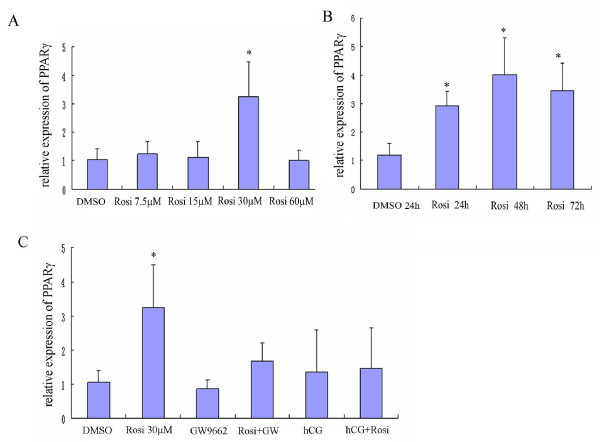
Effects of rosiglitazone on PPARγ mRNA level in cultured GLCs. A. Relative expression of PPARγ after rosiglitazone (Rosi) treatment for 72 h in different doses. B. Time course of rosiglitazone on PPARγ mRNA level in cultured GLCs. C. Relative expression of PPARγ in cultured GLCs in response to rosiglitazone treatment for 72 h in the presence or absence of GW9662 and hCG. Results are expressed in ratio to β-actin, and presented as means ± SD of six independent experiments. Statistical significances compared to the DMSO control are shown with one asterisk (P < 0.05).